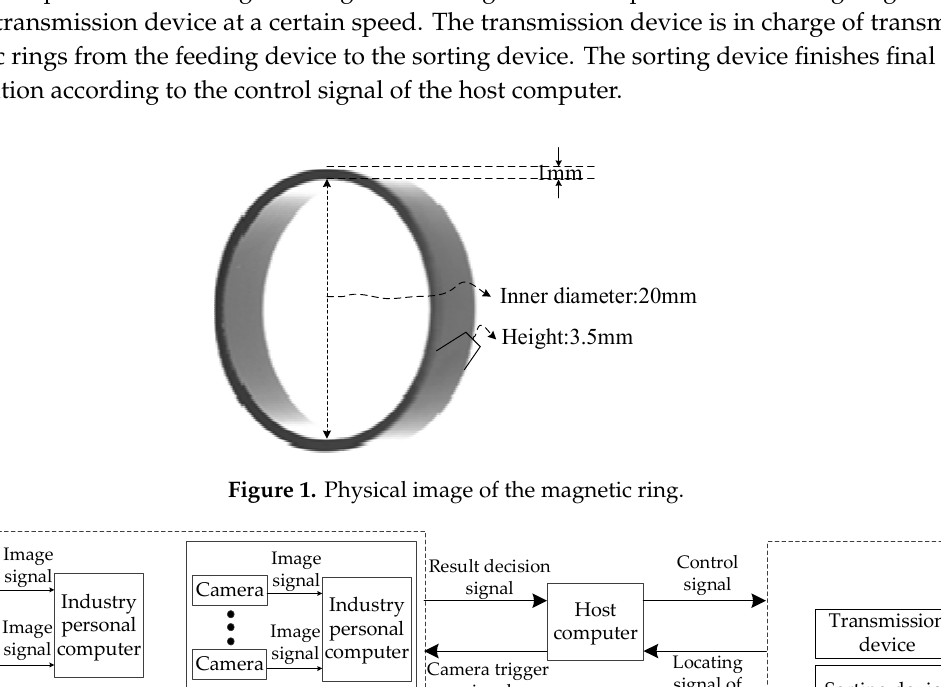
Figure 1. Physical image of the magnetic ring.